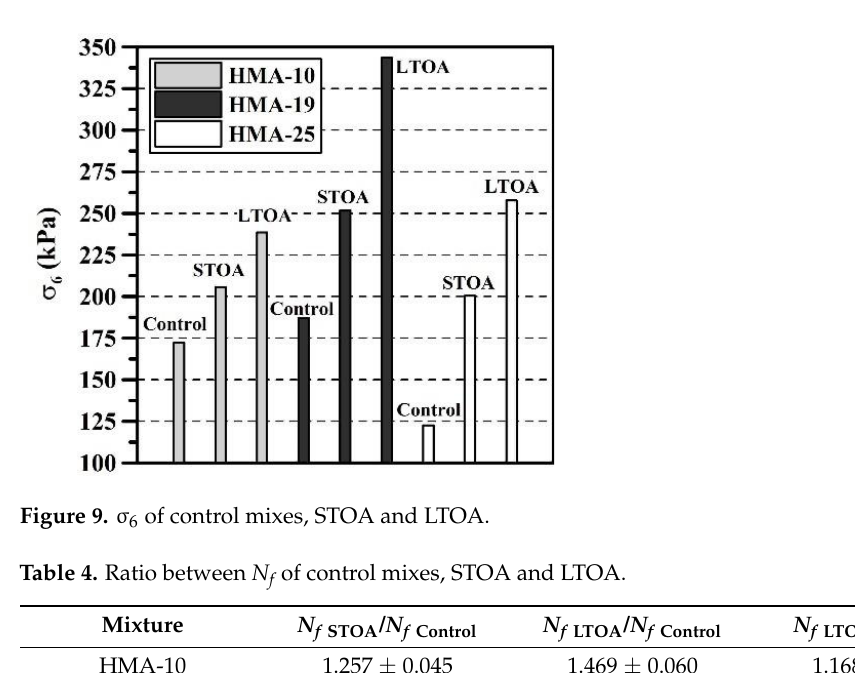
Figure 8. Fatigue test results.